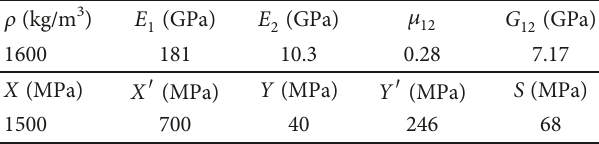
Table 3: Properties of epoxy matrix